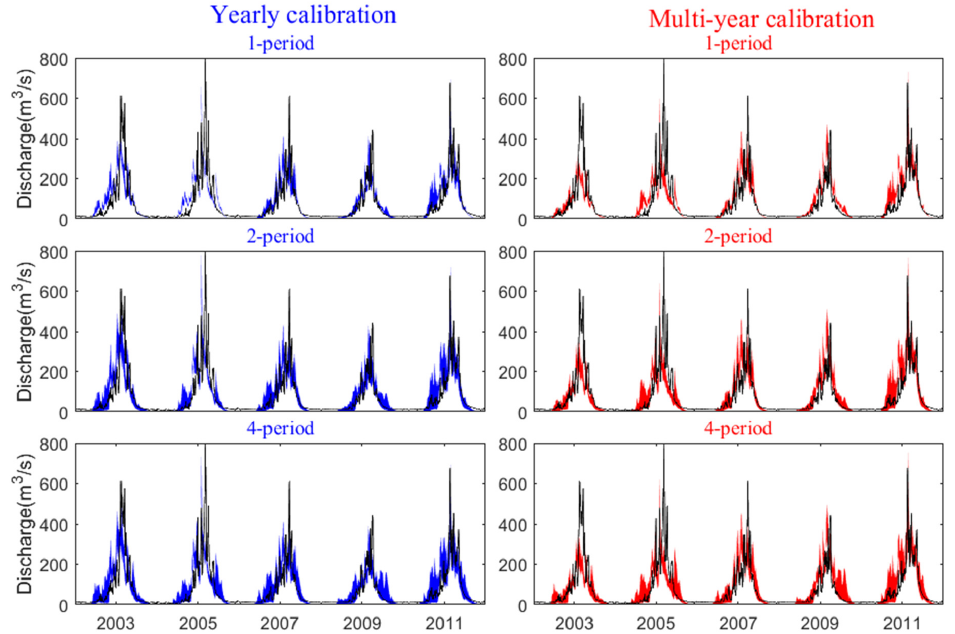
Figure 6. The 95% confidence intervals of daily discharge simulated by posterior parameter sets (color envelope), compared with observed runoff (black lines).